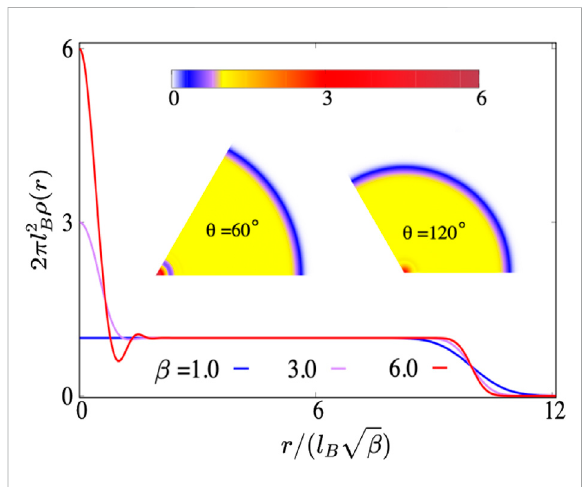
FIGURE 6 Radial density of the IQH state for 50 electrons with β s. β = 1 correspondstotheoriginaldisk geometry which has density ρ ( r ) (cid:2) 1 inthebulk.Thetwoinsertedplotsarethe2Ddensitypro fi lesfor 2 π l 2 B different θ s.